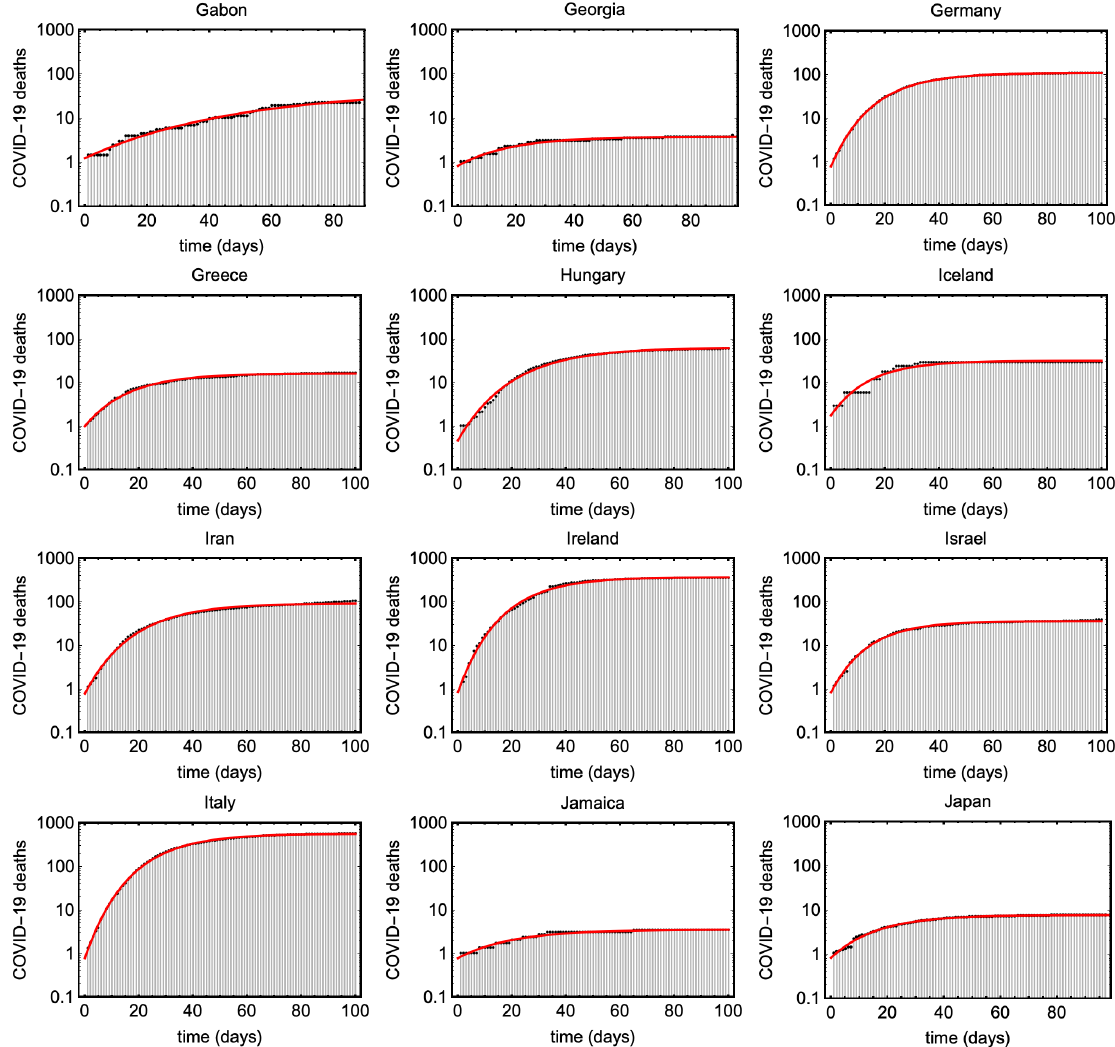
Figure A4. Shows cumulative COVID19 deaths (black) and the estimated Gompertz curves for different countries